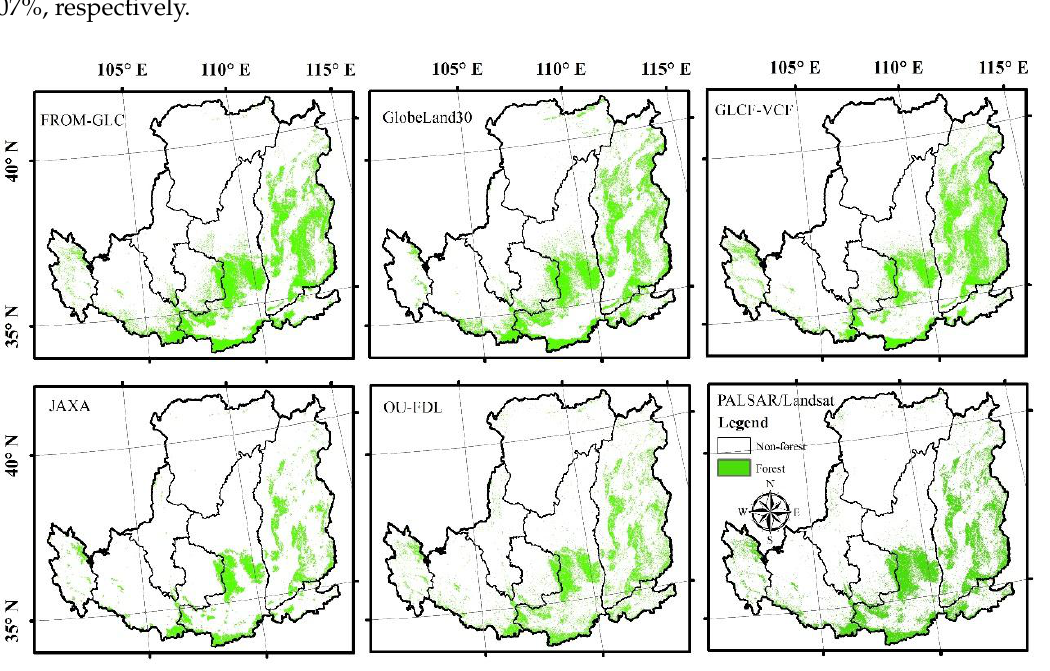
Figure 6. Spatial distributions of the PL-based and the other five forest maps.